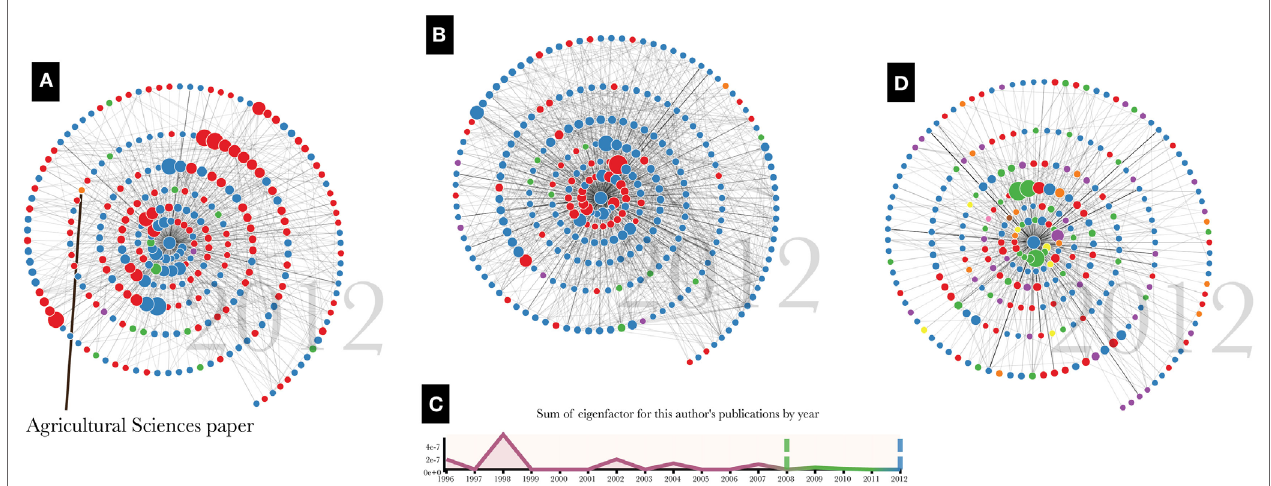
FigUre 3 | Four stories that emerged from demonstrations with the scholars. (a) A scholar who had influence in a field she had not expected. (B) A career shift reflected in changing color bands in the graph. (c) An early-career peak in influence that prompted a scholar to reflect on the freedoms afforded by different research positions. (D) A scholar with influences in very diverse